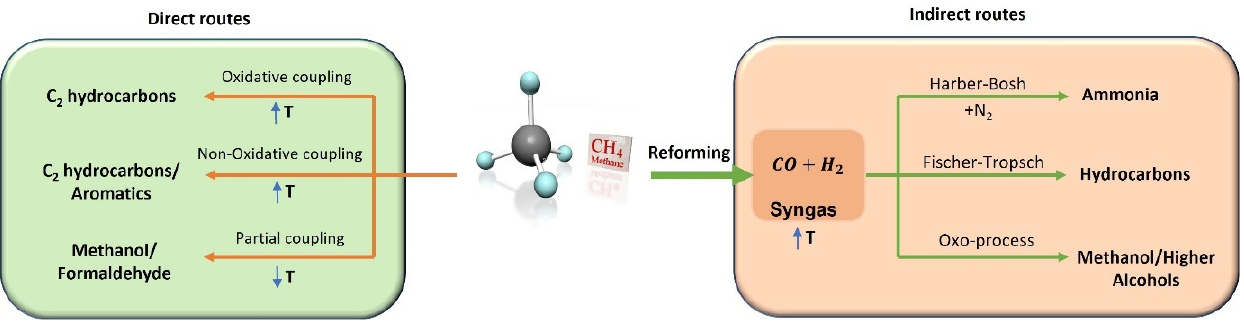
Figure 2. Direct and indirect conversion of natural gas into higher-value chemicals